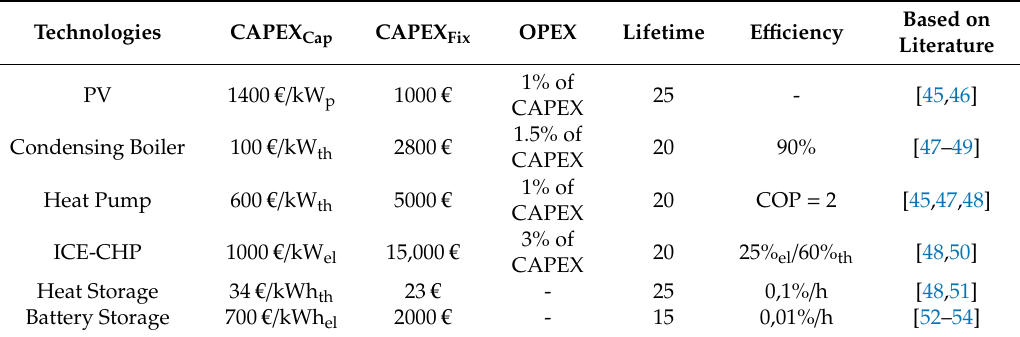
Table 2. State-of-the-art techno-economic technology parameters.